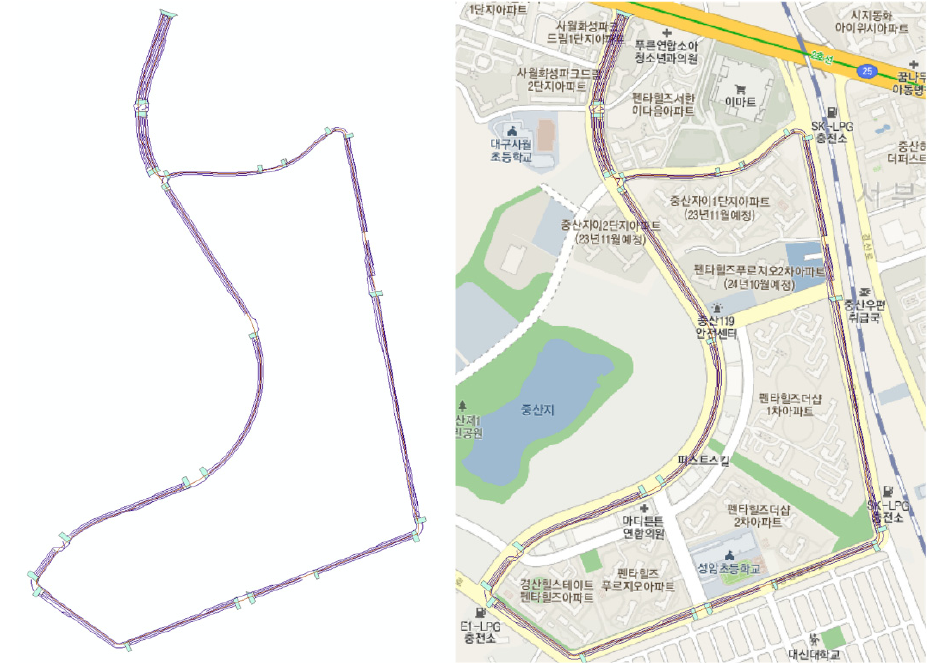
Figure 13. Dynamic high-definition map result at a residential complex.